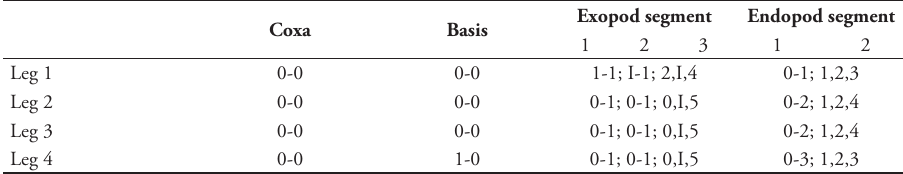
Table 1. Acartia ( Odontacartia ) edentata sp. n. armature formula for legs 1–4, with spines and setae indicated by Roman and Arabic numerals, respectively, following Huys and Boxshall